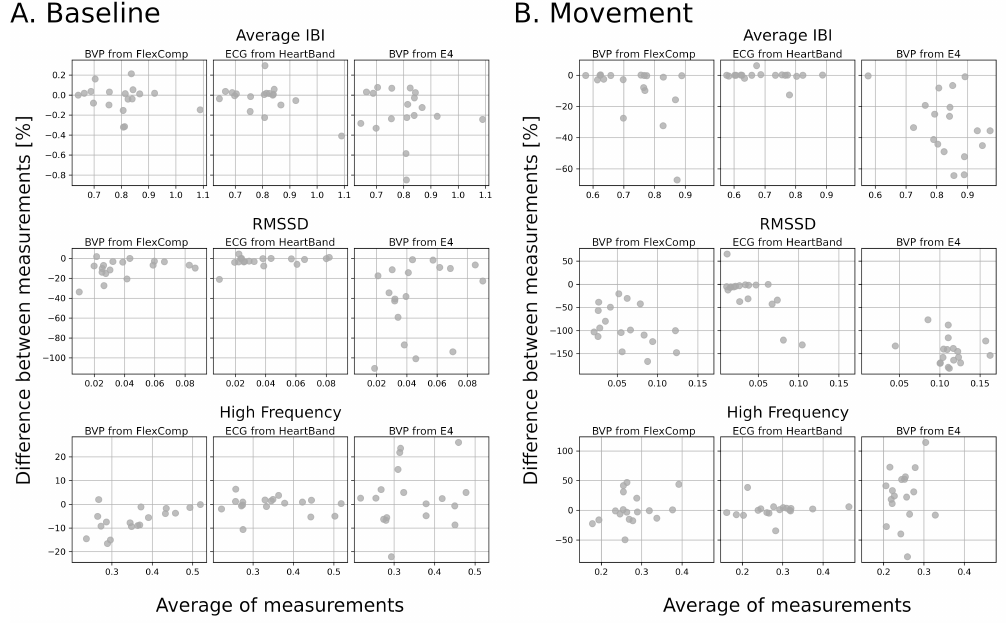
Figure 6. Bland–Altman plots to assess the reliability of the physiological indicators computed from the IBI signals extracted from different signals and devices. All plots refer to the indicators computed from the ECG signals collected by the